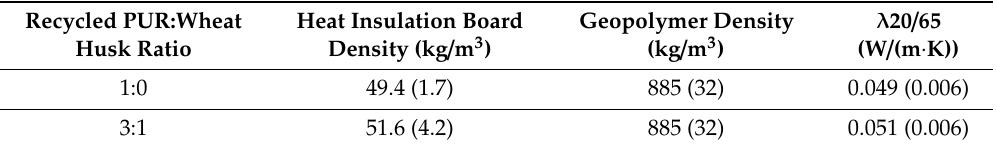
Table 3. Average densities of materials and thermal conductivity of sandwich panels.